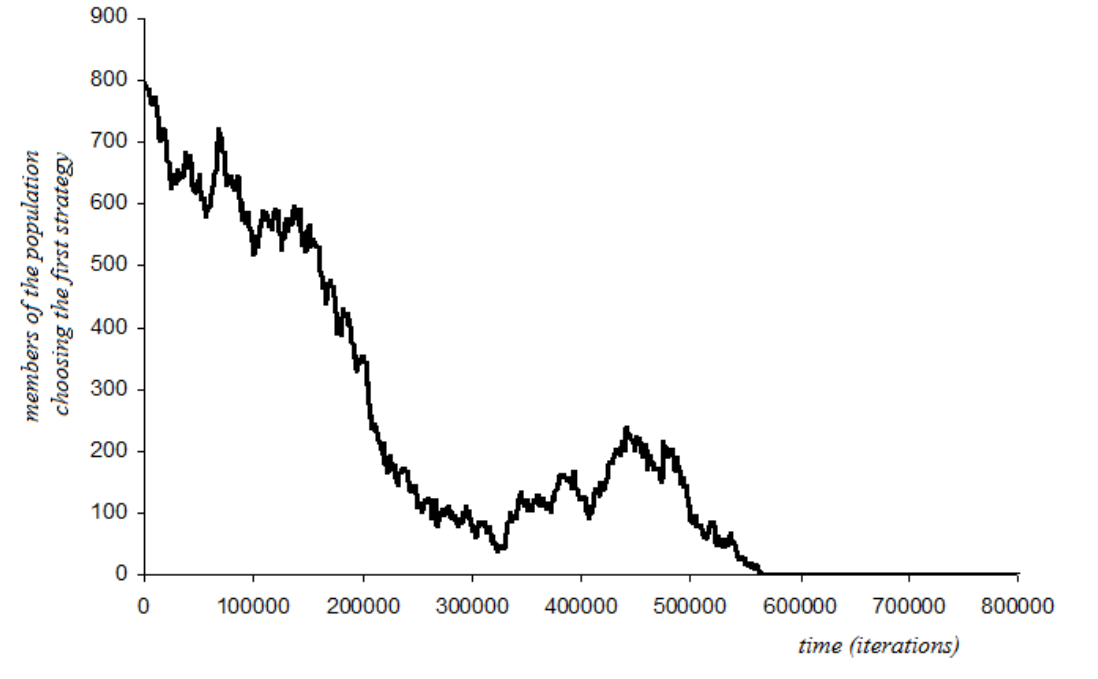
Figure 3. ‘ Stag-Hunt ’ when 80% of players are, initially, drawn to the efficient outcome. The introduction of few intruders sets them on a course to the inefficient outcome.